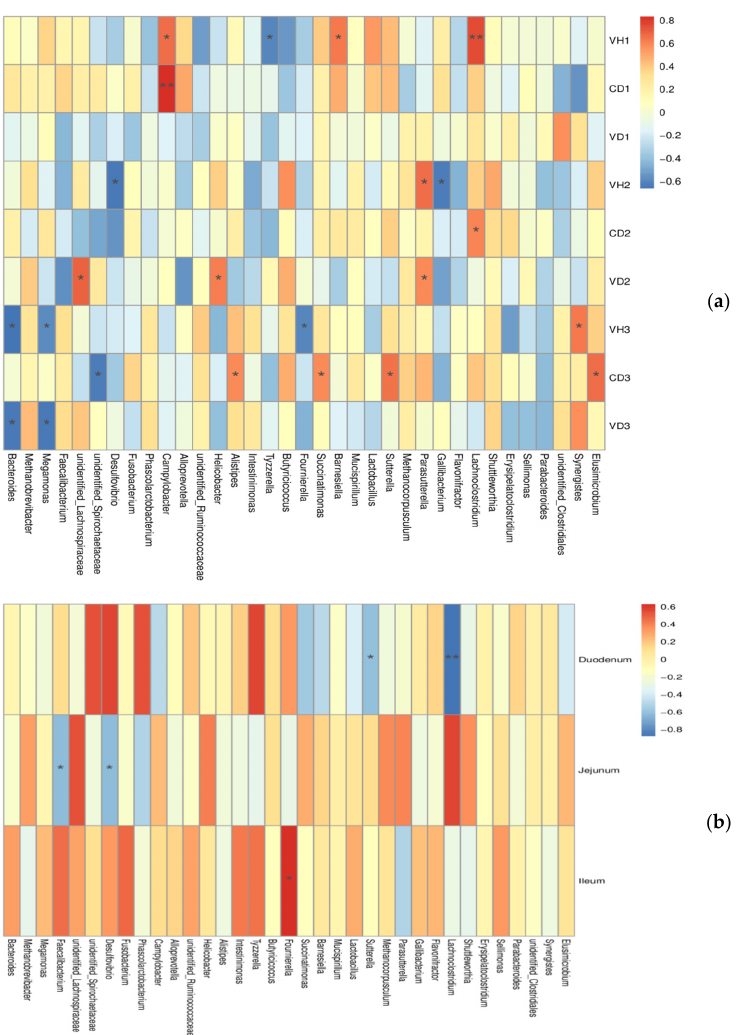
Figure 5. Heatmap of spearman’s correlation between the microbiota from chicken cecum and gut health. ( a ) cecal microbiota and intestinal morphology; ( b ) cecal microbiota and sIgA contents of intestine. Red and blue cells indicate positive and negative correlations, respectively. Color intensity is in proportion to magnitude. * p < 0.05, ** p < 0.01.